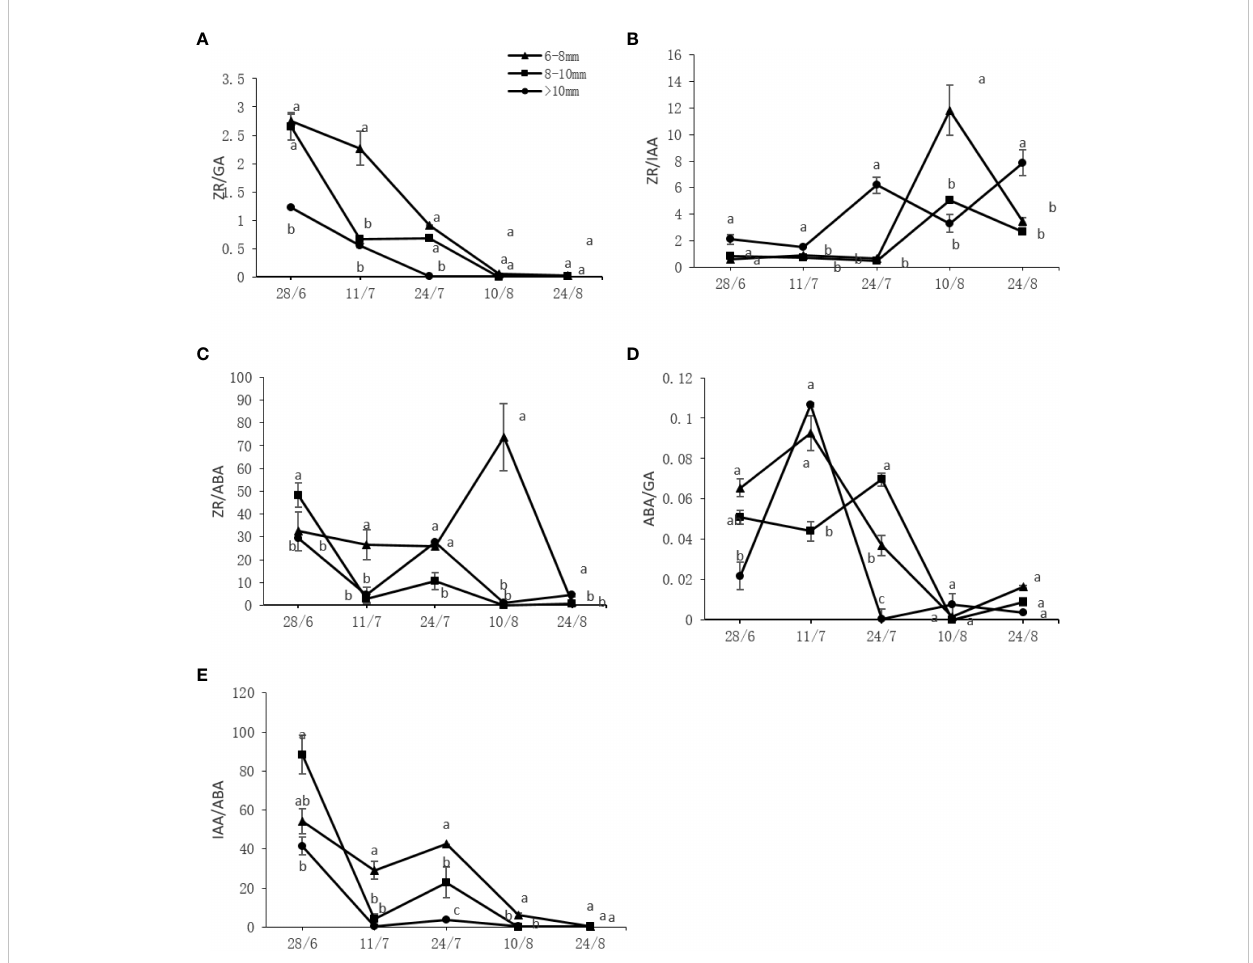
FIGURE 5 Effect of the UST on the (A) zeatin riboside (ZR)/gibberellin (GA), (B) ZR/auxin (IAA), (C) ZR/abscisic acid (ABA), (D) ABA/GA, and (E) IAA/ABA ratios in the bud on upper canopy. The lower-case letters indicate signi fi cant differences ( P <